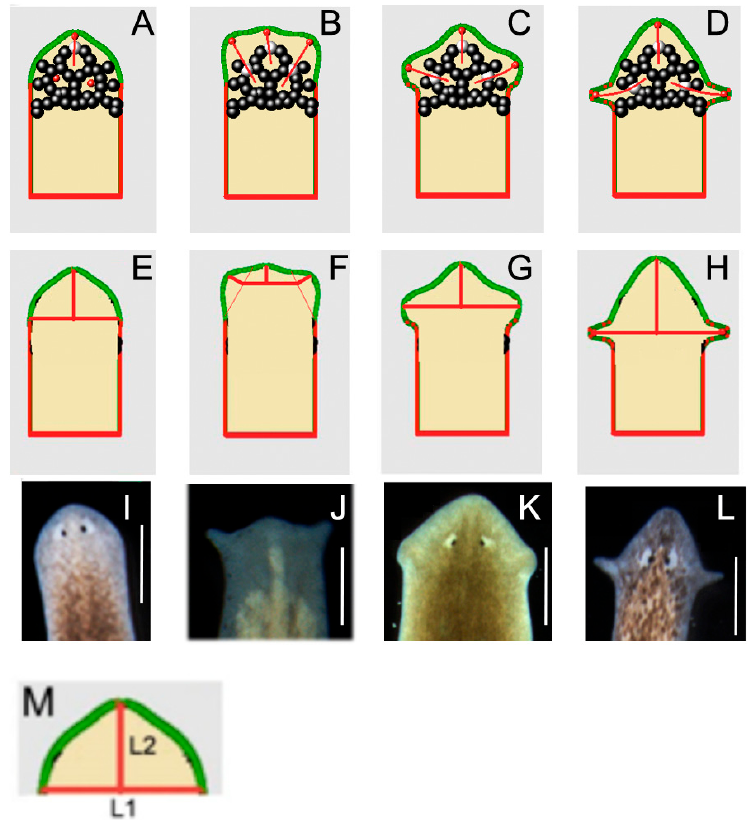
Figure 8. Computational model reproduces the four discrete outcomes observed experimentally. ( A – D ) Four types of planarian heads obtained from the computational model. Different shapes result due to deactivation of different cells. Red lines show the trajectories of the red cells; ( E – H ) Morphometric measurement of different planarian heads, for comparison with real heads ( I – L ) measured (see Table 2). Scale bar 0.5mm. Cells of type A are shown in black, deactivated cells of type A white, cells of type B are red. The outer boundary has two parts differing by its rigidity (soft part of the boundary is shown in red, more rigid part in green). Thus, the red cells represent migrating neoblasts (or their progeny) while the black cells represent somatic cells interconnected by GJs. ( M ) Definitions of lengths of measurements L1 and L2, used in comparison of real worms to those produced by the model in Table 2.